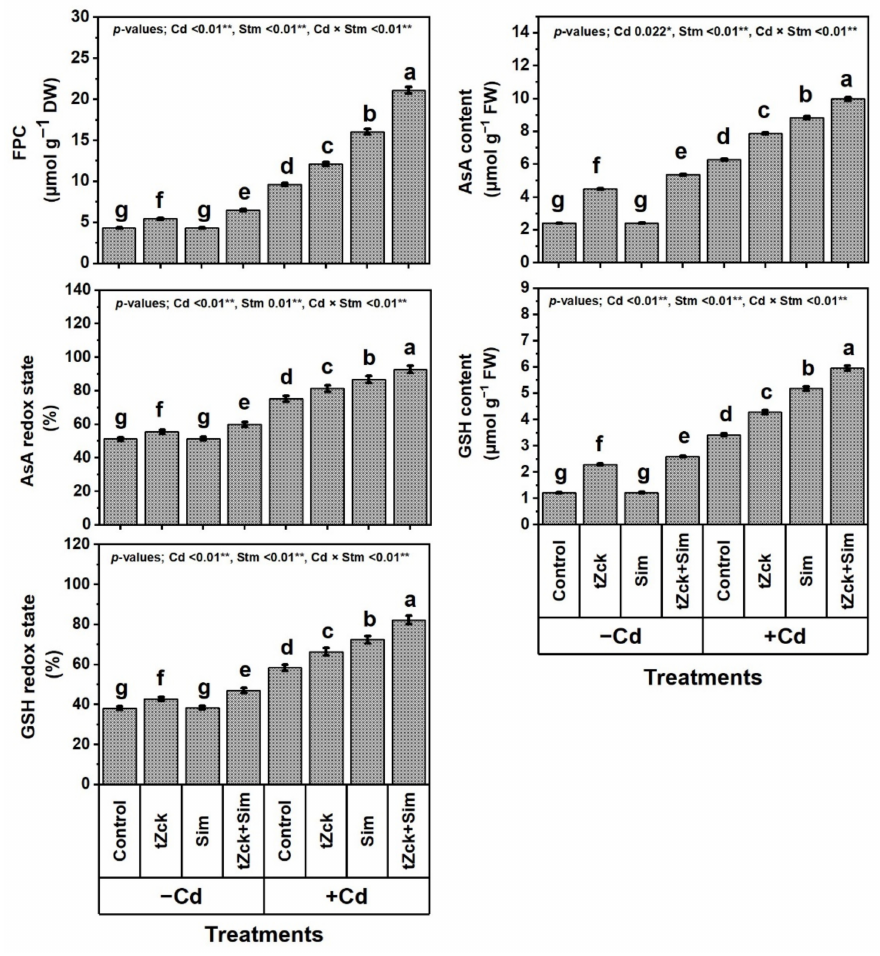
Figure 6. Free proline content (FPC), levels of ascorbate (AsA) and glutathione (GSH) and their redox states (%) of wheat plants (cv. Sakha 93) treated with two stimulators (Stm) i.e., silymarin (Sim; 0.5 mM) and trans -zeatin-type cytokinin (tZck; 0.05 mM) under Cd (0.6 mM) stress. The same letters with mean values ± SE in each plot indicate non-significant differences based on the LSD test ( p ≤ 0.05). * and ** refer to significant difference at p ≤ 0.05 and p ≤ 0.01, respectively. t Zck; trans - zeatin-type cytokinin, Sim; silymarin, − Cd; without cadmium treatment, +Cd; cadmium treatment and Stm;